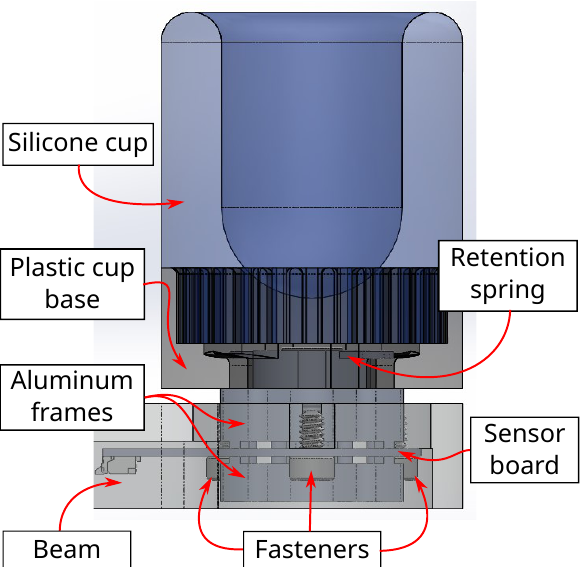
Figure 11. Side view of final assembled sensor-fixture-interface system. The 3-DOF sensor fits and aligns between the aluminum frames, and is fastened inside the beam structure. The plastic base holds the silicone cup for human interfacing, and is held against the top aluminum frame by a retaining